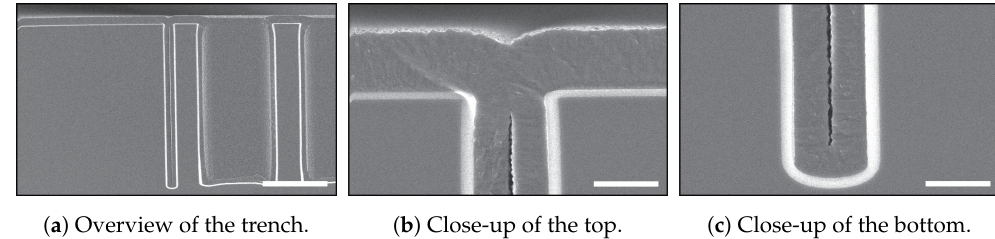
( a ) Overview of the trench. ( b ) Close-up of the top. ( c ) Close-up of the bottom. Figure 4. SEM images of refilled trenches in the TASCT process, in which a keyhole demonstrated the entrance effect. A 3µm wide HAR trench was refilled by wet thermal oxidation and LPCVD of poly-Si. In ( a ), it is shown that the keyhole was created over the full length of the trench. In the close-up SEM images of ( b , c ), it is shown that the width of the keyhole was the same at the top and the bottom [11]. Dry thermal oxidation can be used to close these keyholes, as is demonstrated in Figure 2. The scale bar in ( a ) is 20µm and in ( b , c ) is